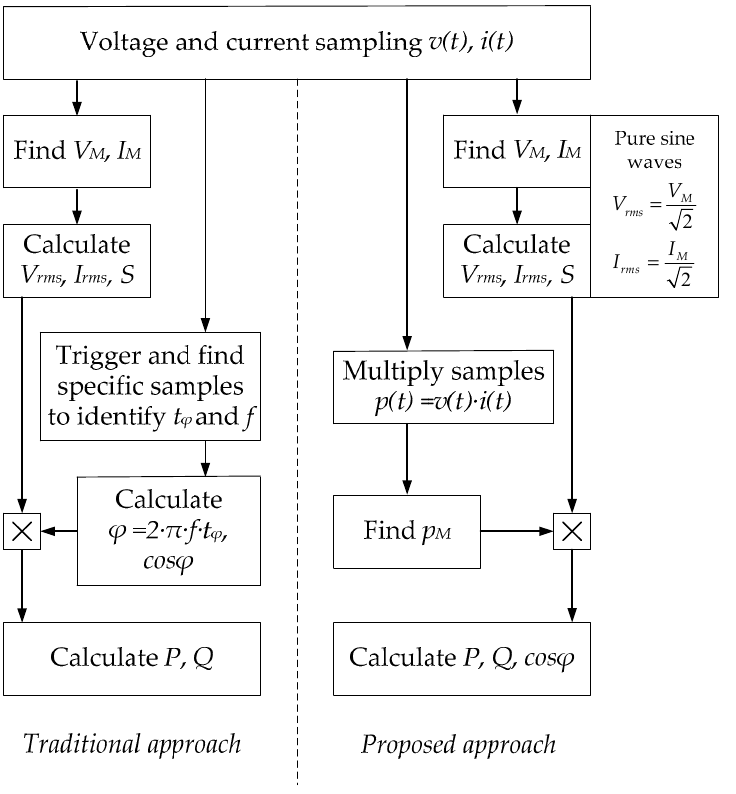
Figure 1. Traditional vs. new approach.